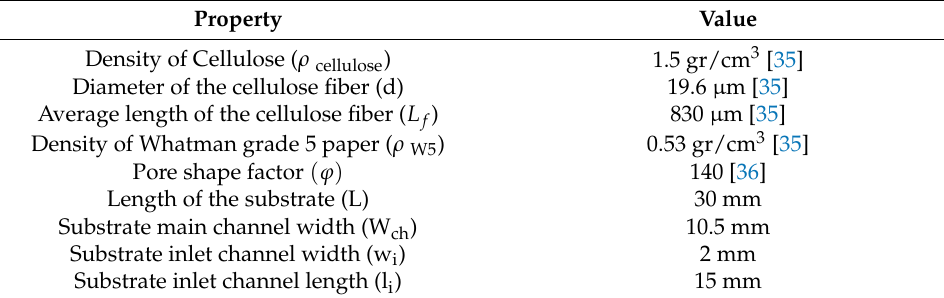
Table 1. Paper substrate and cellulose fiber